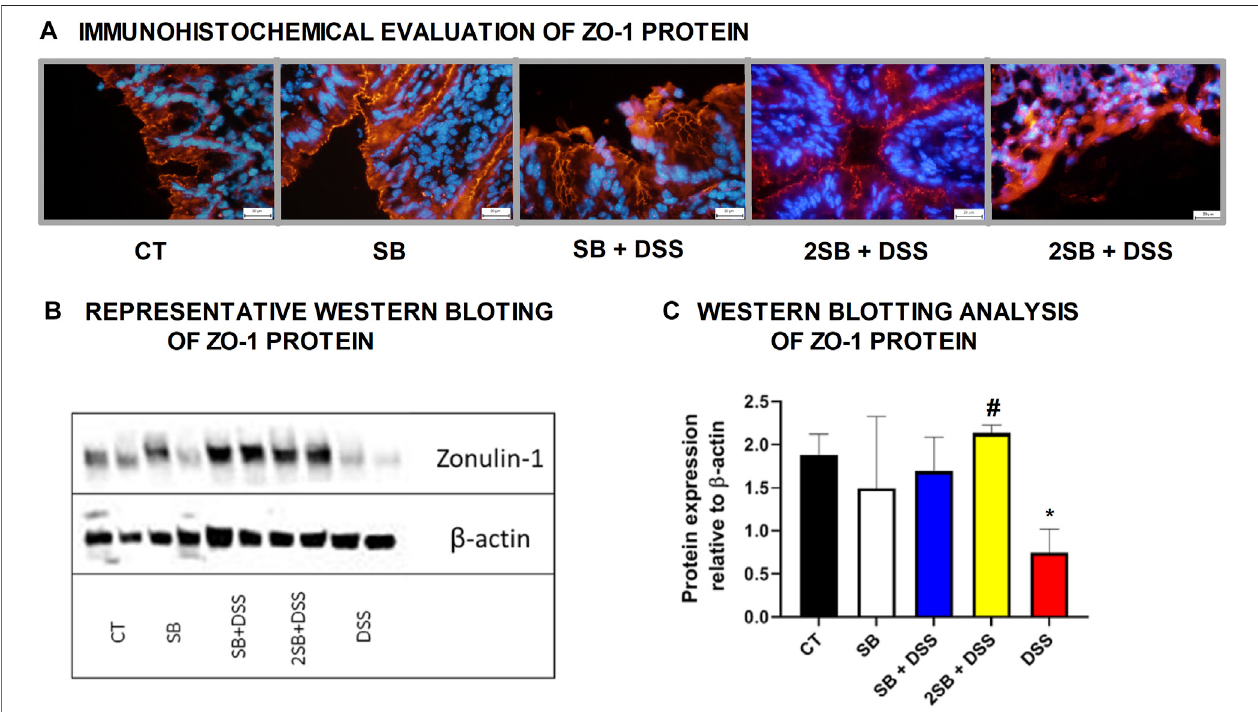
FIGURE2| Sodiumbutyrateadministrationrestoredzonulaoccludens-1(ZO-1)productioninthecolonofDSS-treatedmice.EffectofbutyrateandDSStreatment on production of tight-junction protein ZO-1 was evaluated in cryosections of colonic mucosa of experimental mice. (A) Immunohistochemical evaluation was detected usingmonoclonalantibodyZO-1/CY3andrepresentativeimagesareshown. (B) RepresentativeoutofthreeseparatedWesternblottingassaysofZO-1proteinintissue of colon is shown. Expression of β -actin was used as an internal control. (C) Quanti fi cation of the signals was performed using ImageJ, and data are expressed as the mean ± SD from two separated measurements (2 mice per each group), Student ’ s paired two-tailed t -test was used for comparison of experimental groups to CT controls(group 1:* p < 0.05) ortoDSS-controls(group5: Y p < 0.05). CT :drinking waterfor1 week; SB :0.5%sodiumbutyrate indrinkingwaterfor2weeks; SB+DSS : 0.5% sodium butyrate in drinking water 1 week before and next week together with 2.5% DSS in drinking water; 2SB + DSS: 0.5% sodium butyrate in drinking water 2 weeks before and the next week together with 2.5% DSS in drinking water; DSS: 1 week 2.5% DSS in drinking